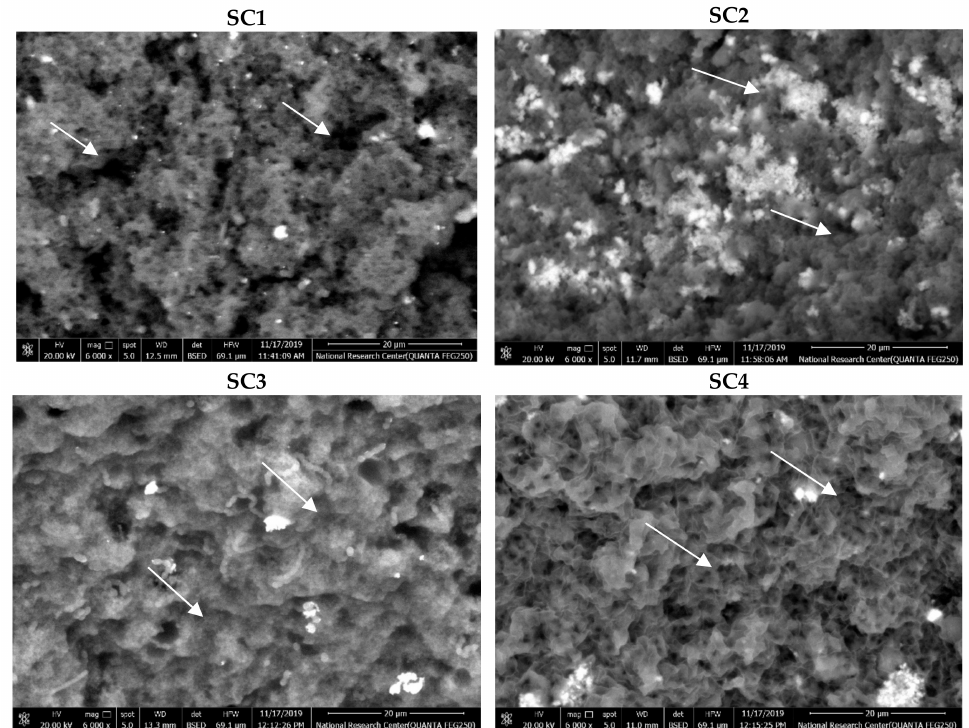
Figure 3. Scanning electron microscopy images of the ice cream treatments. SC1: control without artificial sugar; SC2: ice cream with stevia; SC3: ice cream with sucralose; SC4: ice cream with sorbitol. The arrows indicate the size of pores and the homogeneous structure of samples (or lack